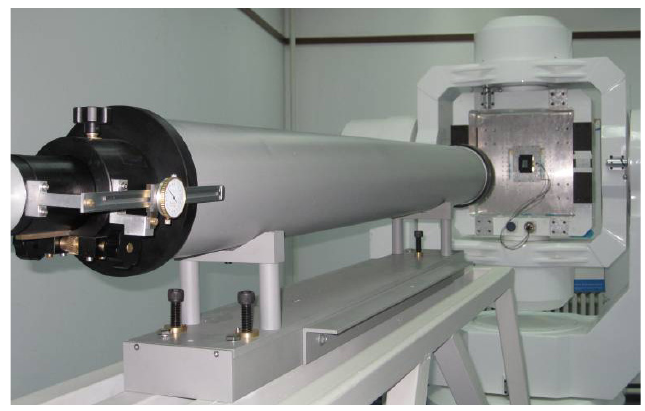
Figure 12. Test system for the sun